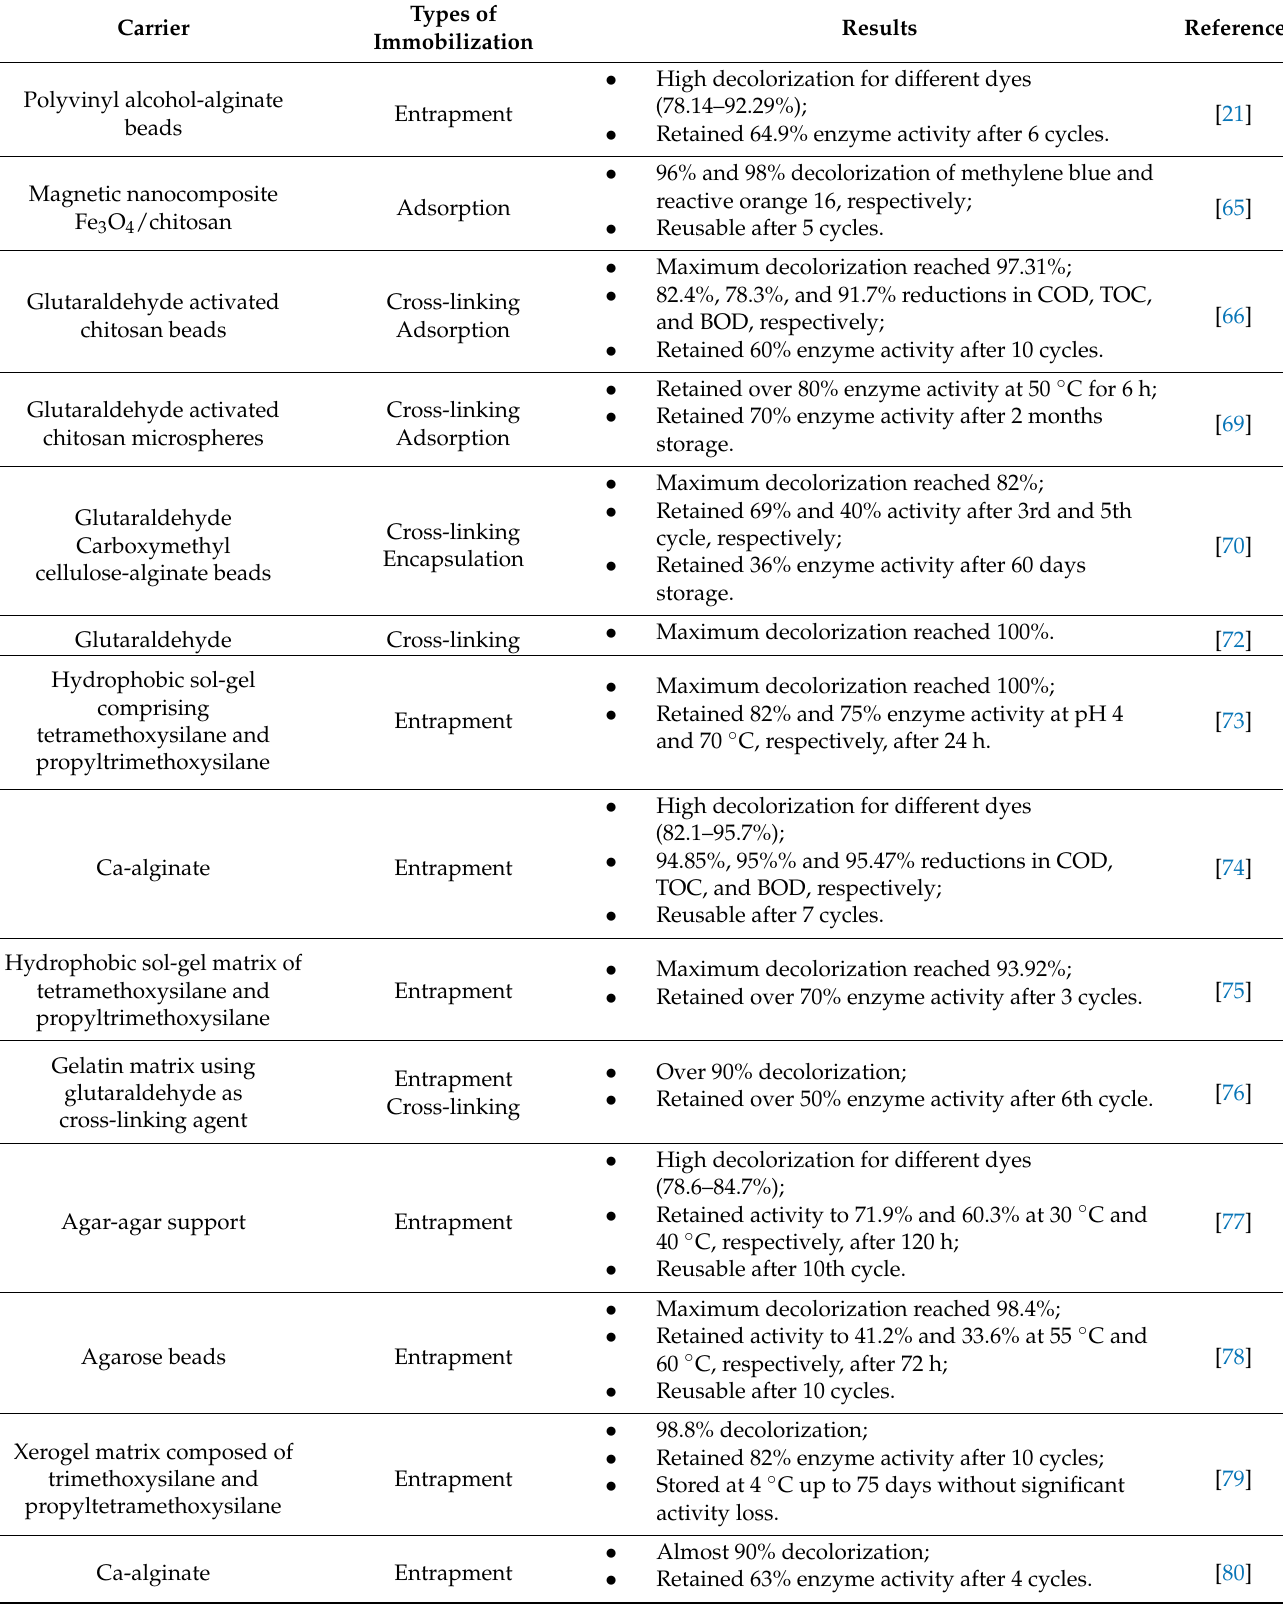
Table 3. Recent applications of immobilized MnP in dye